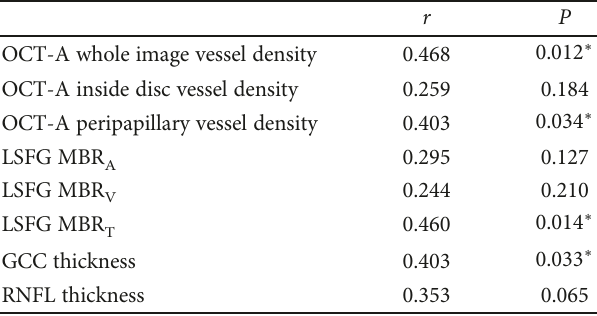
Table 4: Correlation between the visual fi eld mean deviations and the diagnostic